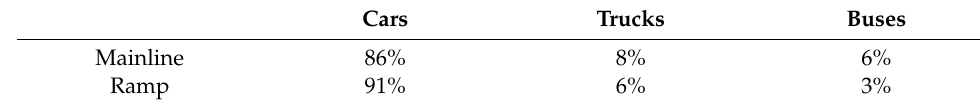
Table 1. Simulation vehicle composition input.